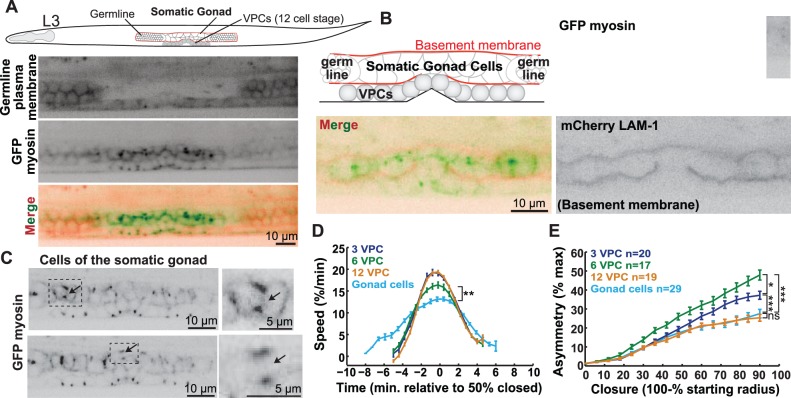
Tissue geometry influences the kinetics of cytokinesis in the cells of the somatic gonad.(A) Schematic representing an L3 worm (∼31 hours post-hatching), showing the somatic gonad, VPCs and germline. Worm expressing mCherry-tagged phospholipase C (PLCδ) PH domain in the germline (top), GFP-tagged myosin in the VPCs and somatic gonad (middle), and merge image (bottom). Scale bar = 10 µm. (B) Schematic of the cells of the somatic gonad (middle) and the germline (extremities) surrounded by a continuous basement membrane (red). Worm at the 12 VPC stage expressing myosin::GFP and mCherry::LAM-1 (laminin-1) to mark basement membrane. Scale bar = 10 µm. (C) Maximum intensity projection images of the somatic gonad expressing GFP myosin. Dotted boxes: dividing cells, enlarged to the right; arrows: contractile ring. Scale bars = 10 µm (left); 5 µm (right). (D-E) Average ring closure speed and asymmetry (somatic gonad: teal blue, first VPC division: purple, second: green, and third: orange). Each VPC stage n(cells) ≥17, n(worms) ≥6. Gonad cells; n(cells) = 29, n(worms) = 12. Error bars = SEM. **: p = 0.0023, unpaired t-test, gonad cells versus 6 VPC stage. *: p = 0.06, ***: p<0.0001, n.s.: p>0.1, unpaired t-test.